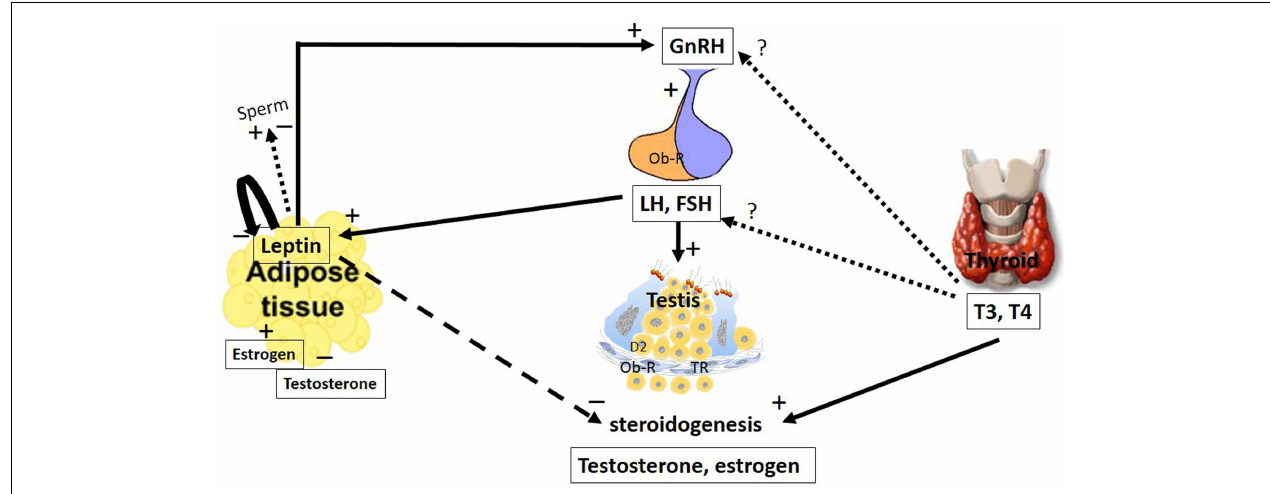
regulate leptin secretion in a feedback mechanism; however, estradiol stimulates and testosterone inhibits leptin secretion. LH and FSH are other hormones that stimulate leptin secretion. Leptin is capable of autoregulating its own secretion.The role of the thyroid hormones,T 4 andT 3 , at the hypothalamic and pituitary levels remain controversial. However, in the testes, these hormones stimulate steroidogenesis.The arrays indicate solid (stimulatory), dashed (inhibitory), and dotted (uncertain) signals. GnRH, gonadotropin-releasing hormone; LH, luteinizing hormone; FSH, follicle-stimulating hormone;T 3 , 3,5,3 (cid:48) -triiodo- L -thyronine;T 4 , thyroxine; Ob-R, leptin receptors;TR, thyroid